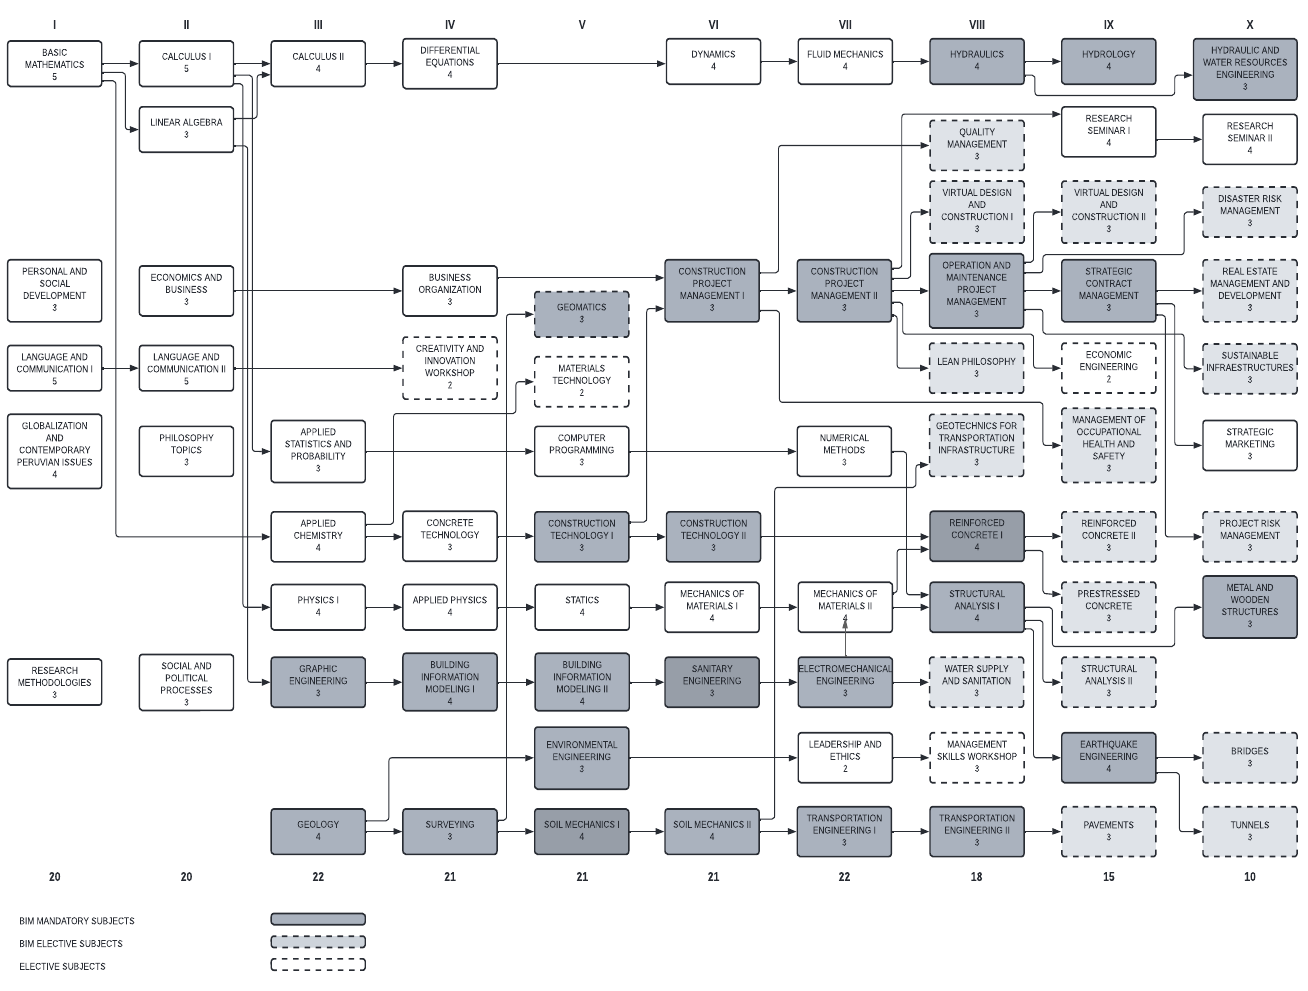
Figure 2. Civil engineering curriculum with subjects and prerequisites. Adapted from Universidad de Lima [51].